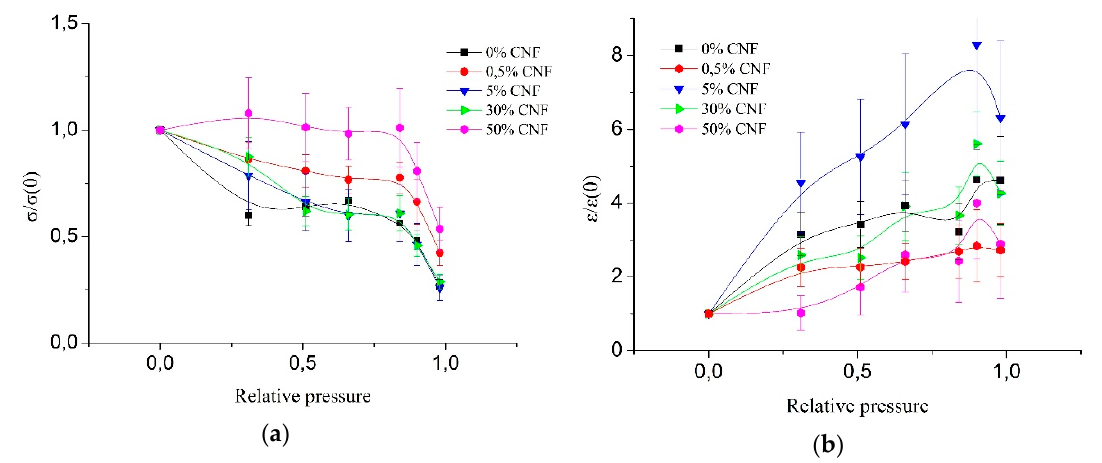
Figure 2. ( a ) The influence of relative water vapor pressure on the tensile strength of composite fibers; ( b ) the influence of relative water vapor pressure on elongation at break of composite fibers.